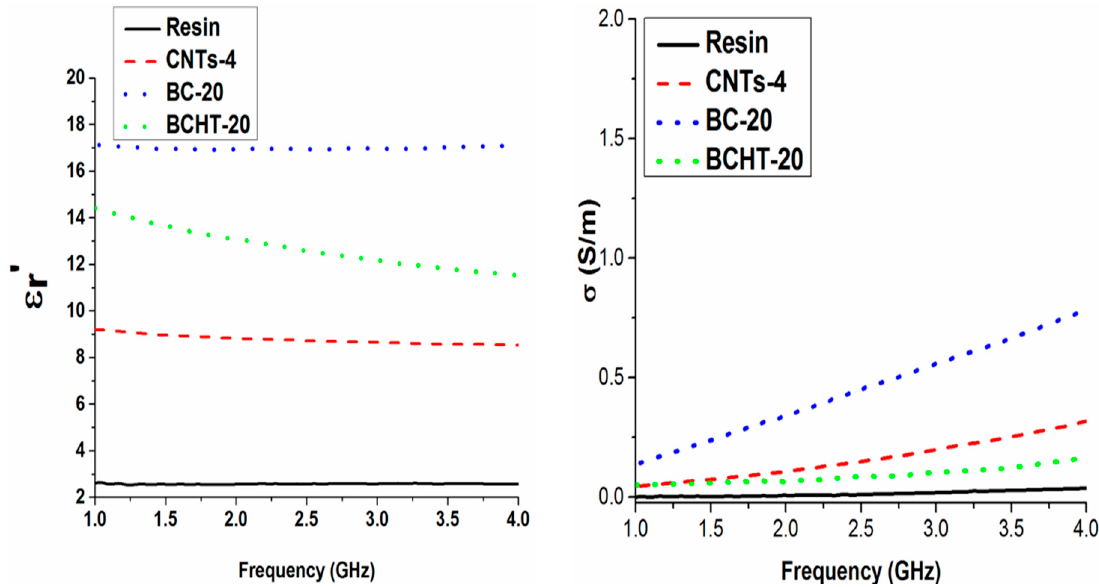
Figure 11. Comparison among the real part of permittivity ( left panel ) and conductivity ( right panel ) in the microwave range for pure epoxy and epoxy composites filled with 4 wt % of MWCNTs and 20 wt % of each biochar type.